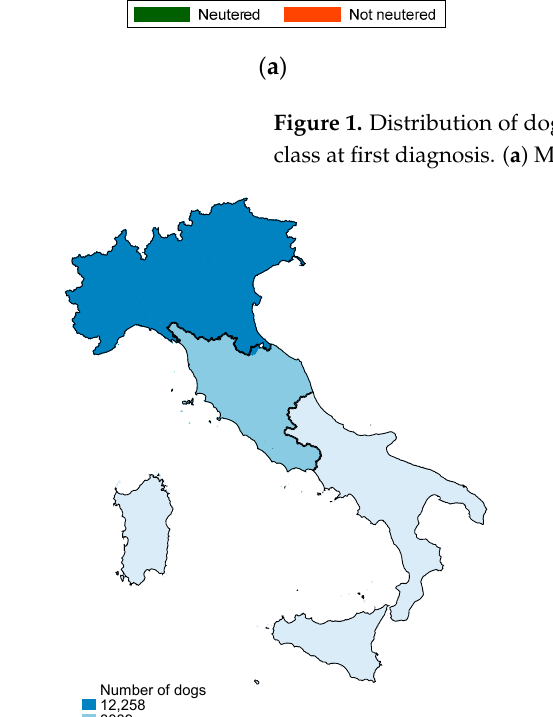
Figure 1. Distribution of dogs with a diagnosis of tumour by sex, neutered/spayed status and age class at first diagnosis. ( a ) Males; ( b ) females. Table 1. Mean age at first diagnosis by sex, neutering status and tumour behavior.